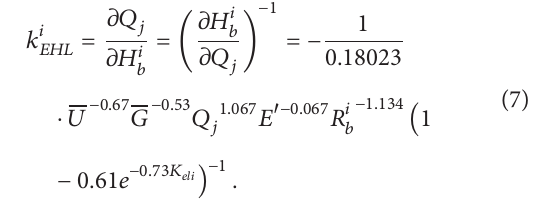
Figure 2: Schematic diagram of the ball bearing.